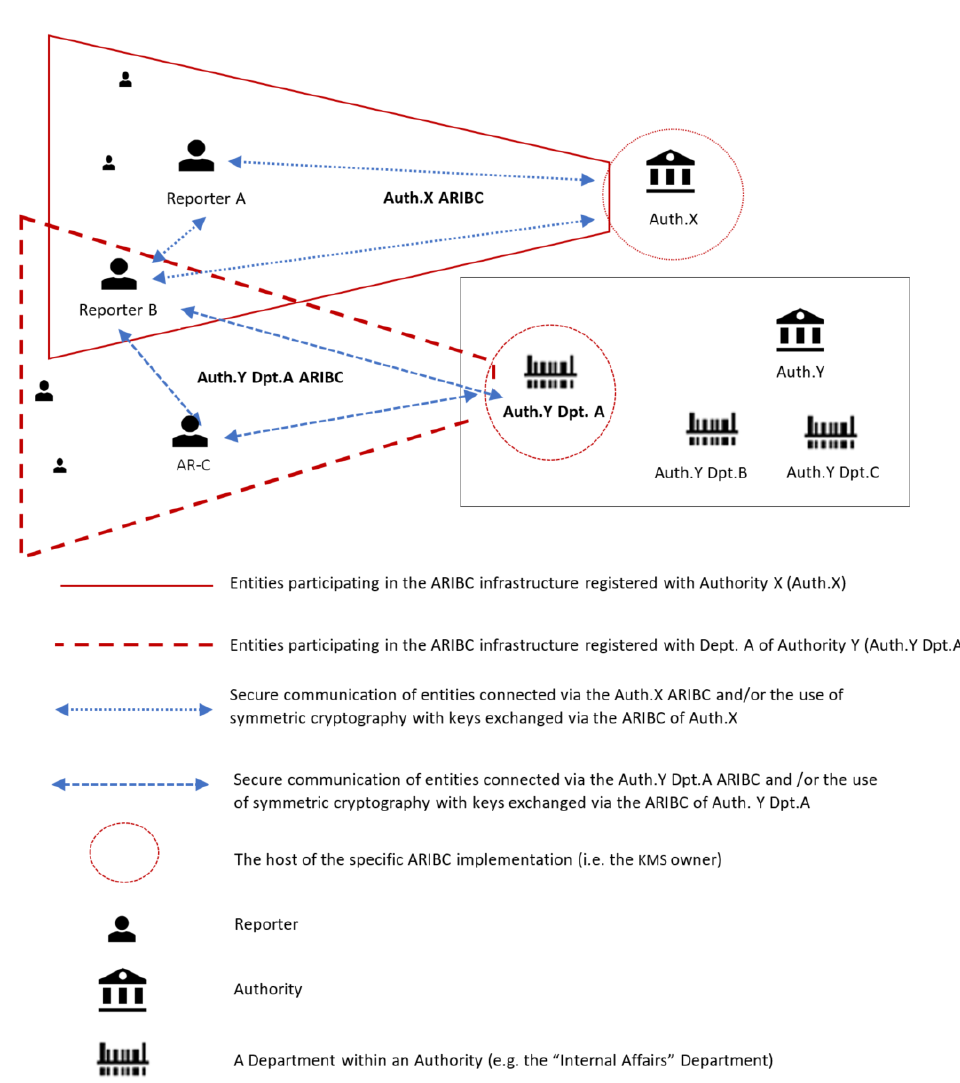
Figure 1. The interactive entities of